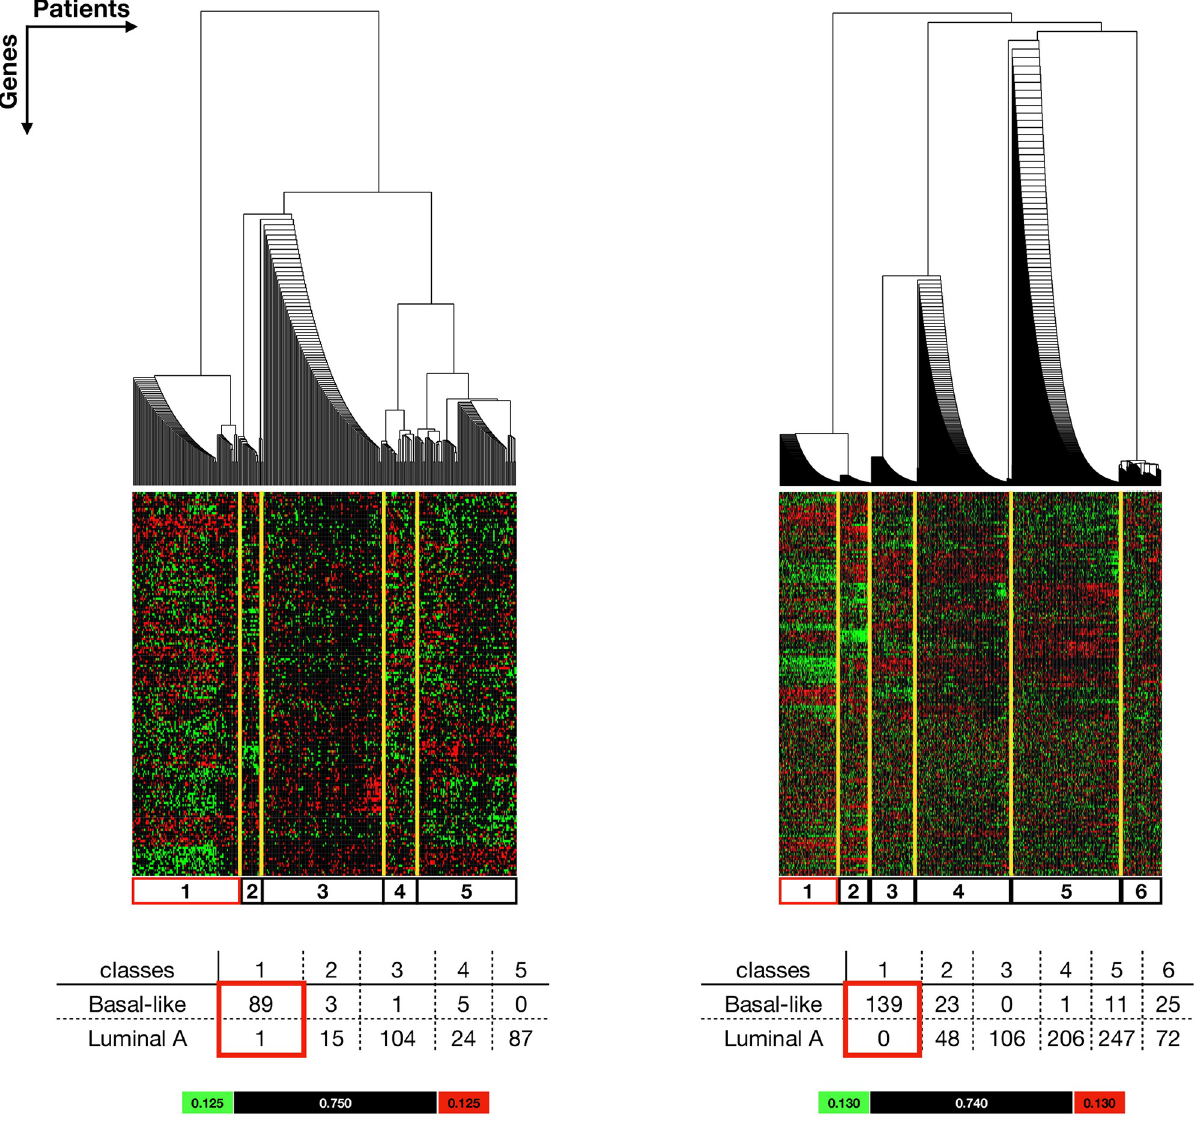
Fig 2. Extracted results from Basal-like vs Luminal A comparison show a natural stratification of Basal-like vs Luminal A patients (columns) according to the NR-associated gene expression signals (rows). See S3.4 and S3.5 Files in S3 Appendix for the complete results. Left: Patients from TCGA dataset were grouped into 5 classes. Class 1 is considered as a Basal dominant class . Right: Patients from METABRIC dataset were grouped into 6 classes. Class 1 is considered as a Basal dominant class . Yellow lines highlight the classes (simplified from the clusters) and the corresponding expression pattern in the colour plot. The tables show the number of Basal-like and Luminal A patients in each class. The Basal dominant classes are highlighted in red boxes in the table and colour plots. The colour bar indicates the lowerbound (green), likelihood (black) and upperbound (red).